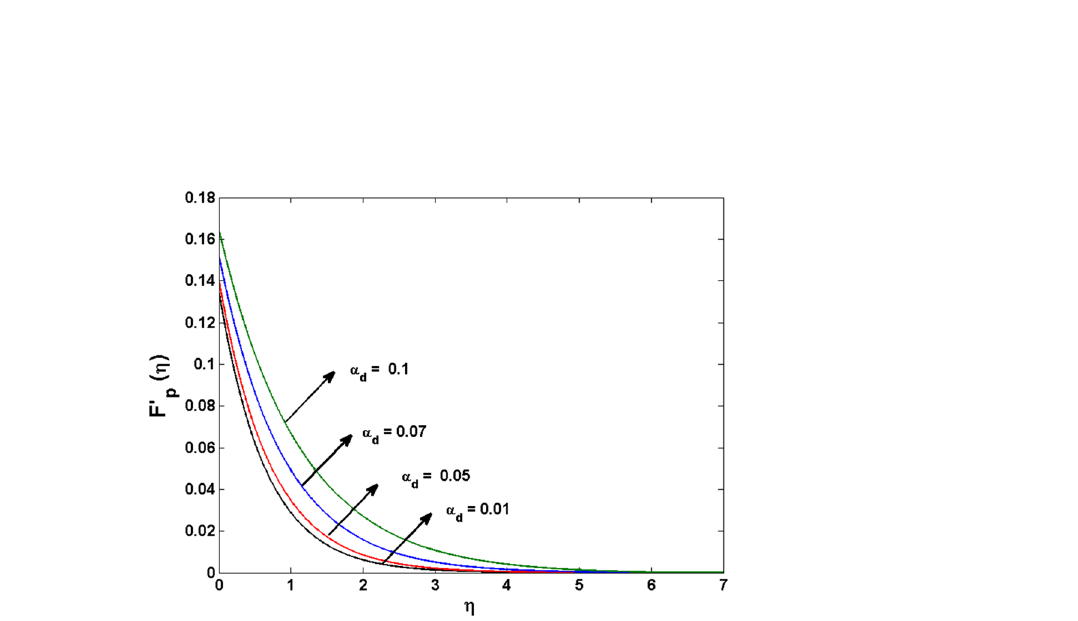
Figure 4. F ′ p (ζ) for various estimates of α d